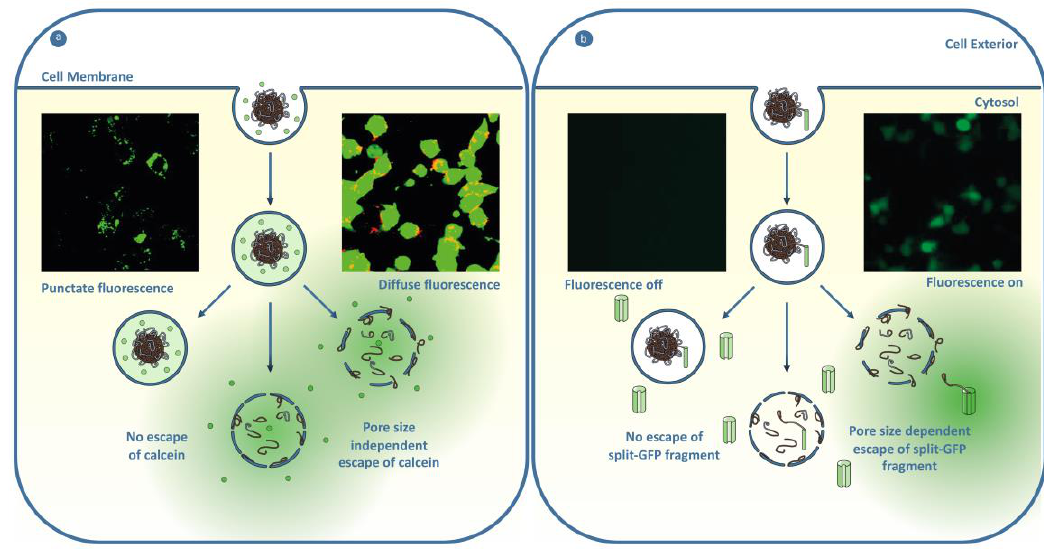
Figure 5. Schematic representation of the current and emerging methods to determine endosomal escape. ( a ) The calcein assay determines endosome escape via the transition from punctate to diffuse fluorescence throughout the whole cell. ( b ) The split-green fluorescent protein (GFP) assay generates a fluorescent signal after endosomal escape and reconstitution of the GFP-strand with the cytosolically-localized GFP. The split-GFP assay allows the endosomal escape of large therapeutics to be monitored, in contrast to the calcein assay, which can only represent the escape of small molecules. Adapted with permission from [187,203]. Copyright 2007, American Chemical Society. Copyright 2010, John Wiley and Sons.